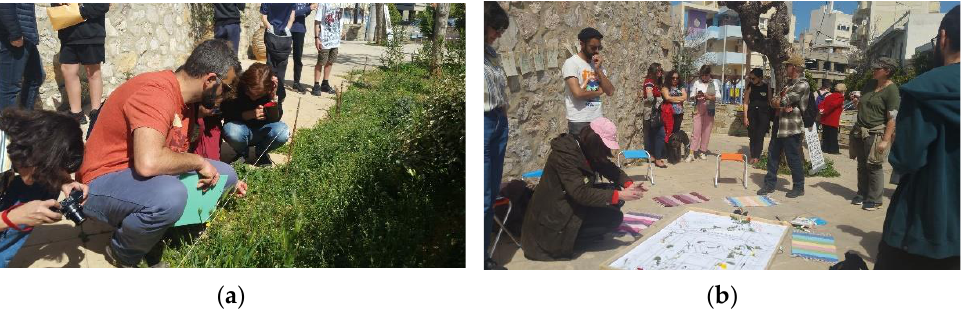
Figure 2. Identifying plants ( a ) and making an arboretum ( b ) (Photo credits: Monica Vaxevani).